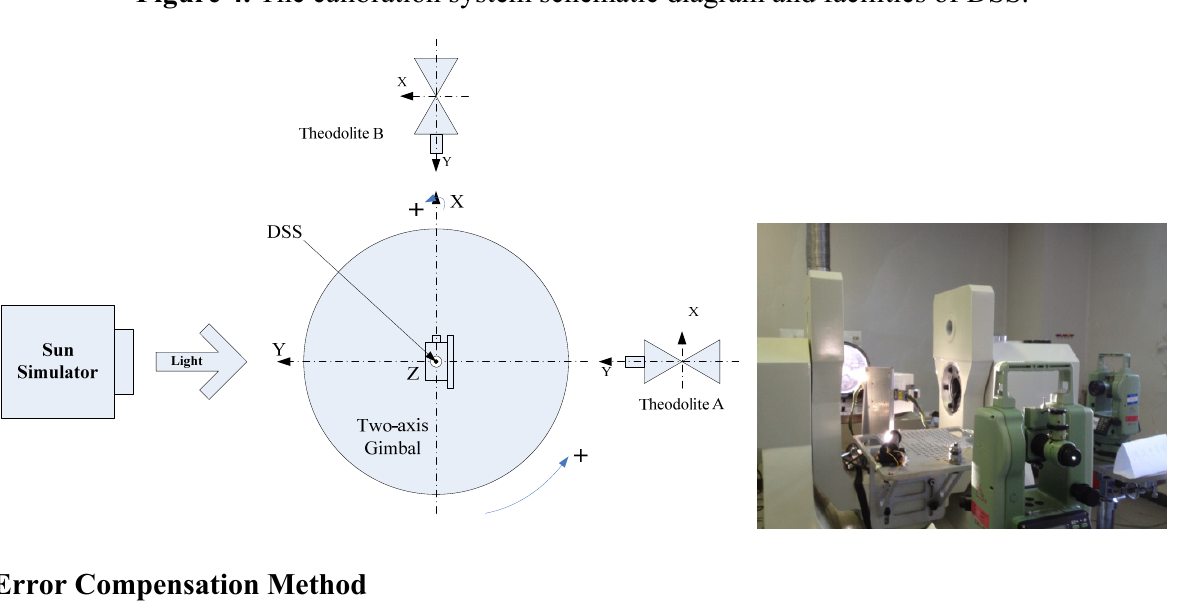
Figure 4. The calibration system schematic diagram and facilities of